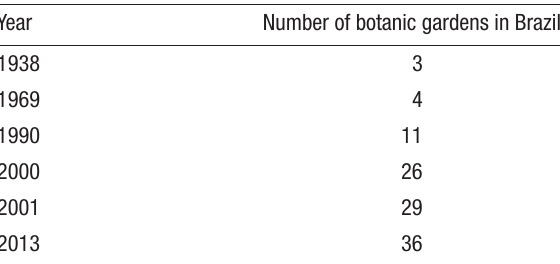
Table 1. Number of botanic gardens in Brazil over the past 80 years. Year Number of botanic gardens in